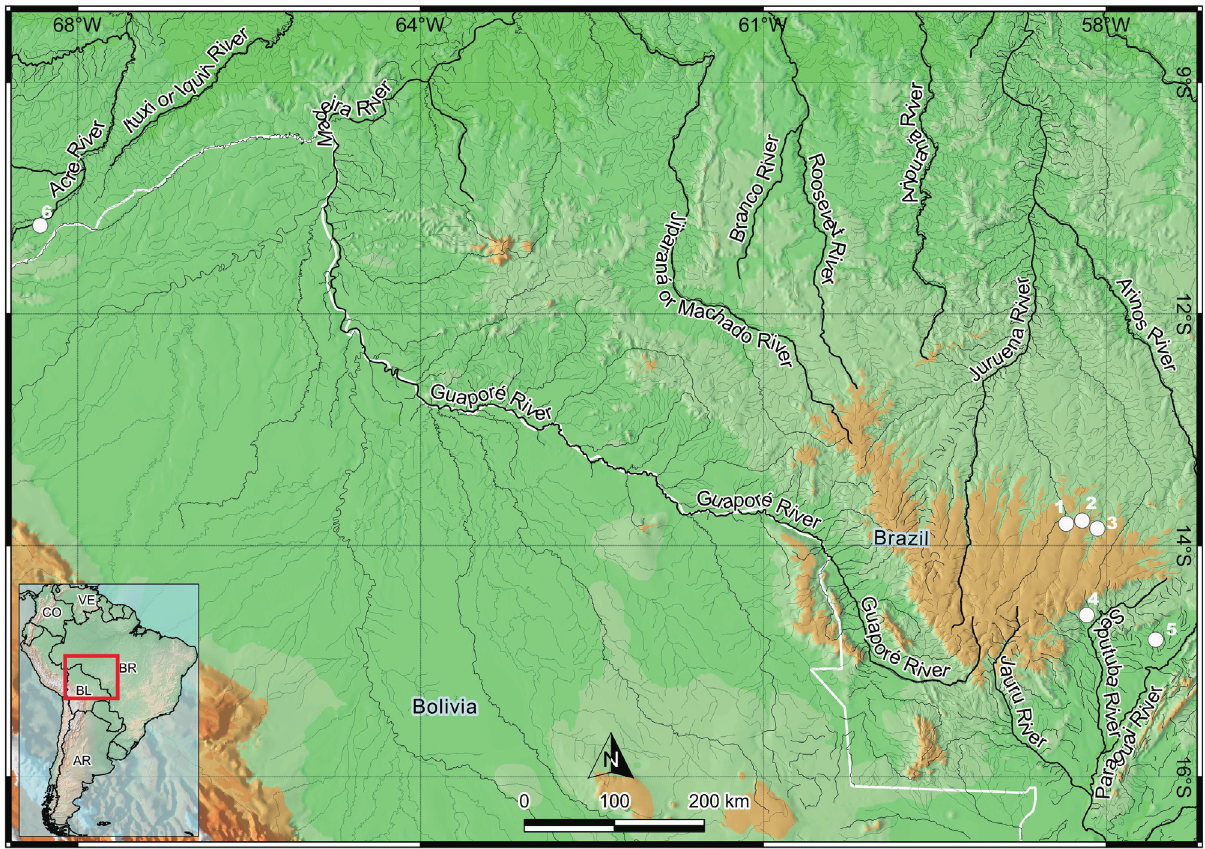
Figure 1 - Location of the collecting localities of the Moenkhausia specimens analyzed in the present study: (1) Verde River ( M . cosmops and M . nigromarginata ); (2) Membeca River ( Moenkhausia sp. n. and M . nigromarginata ); (3) Sangue River ( M . oligolepis ); (4) Sapo Stream ( M . forestii ); (5) Corredeira Stream ( M . oligolepis ); and (6) Xapuri River ( M . oligolepis